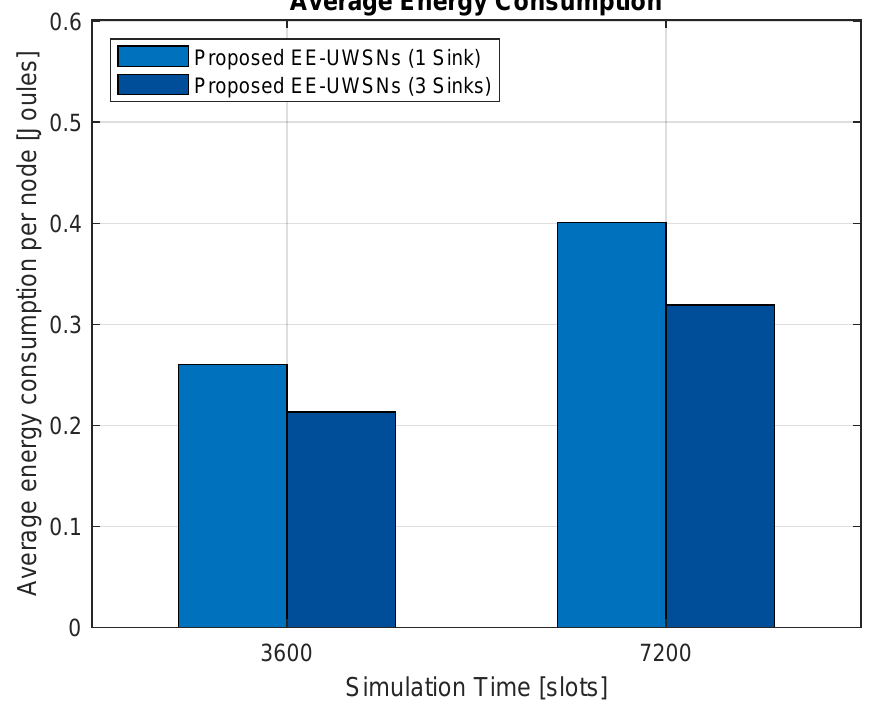
Figure 16. The effect of changing the number of sinks on energy consumption.